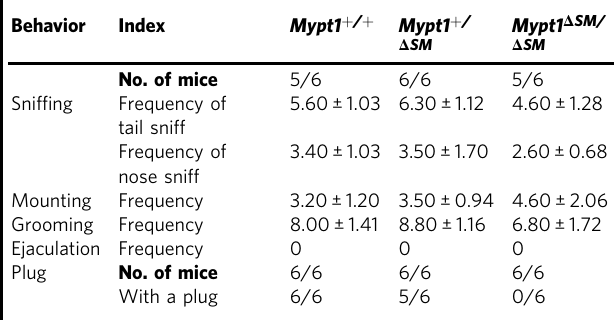
Table 2 Summary of sexual behaviors of different genotyping